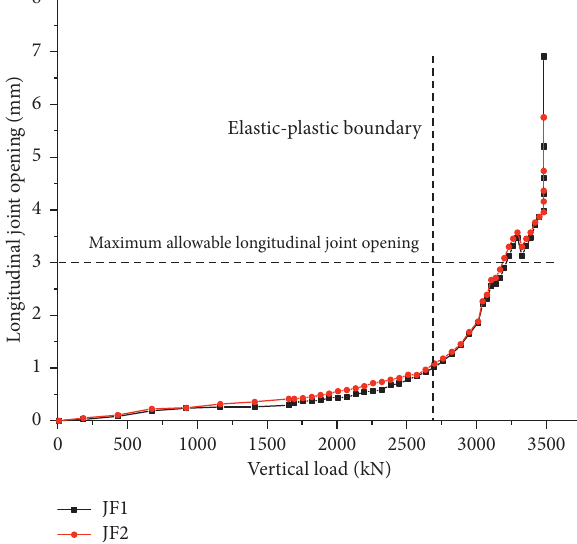
Figure 10: Variation law of longitudinal joint opening for different vertical loads.